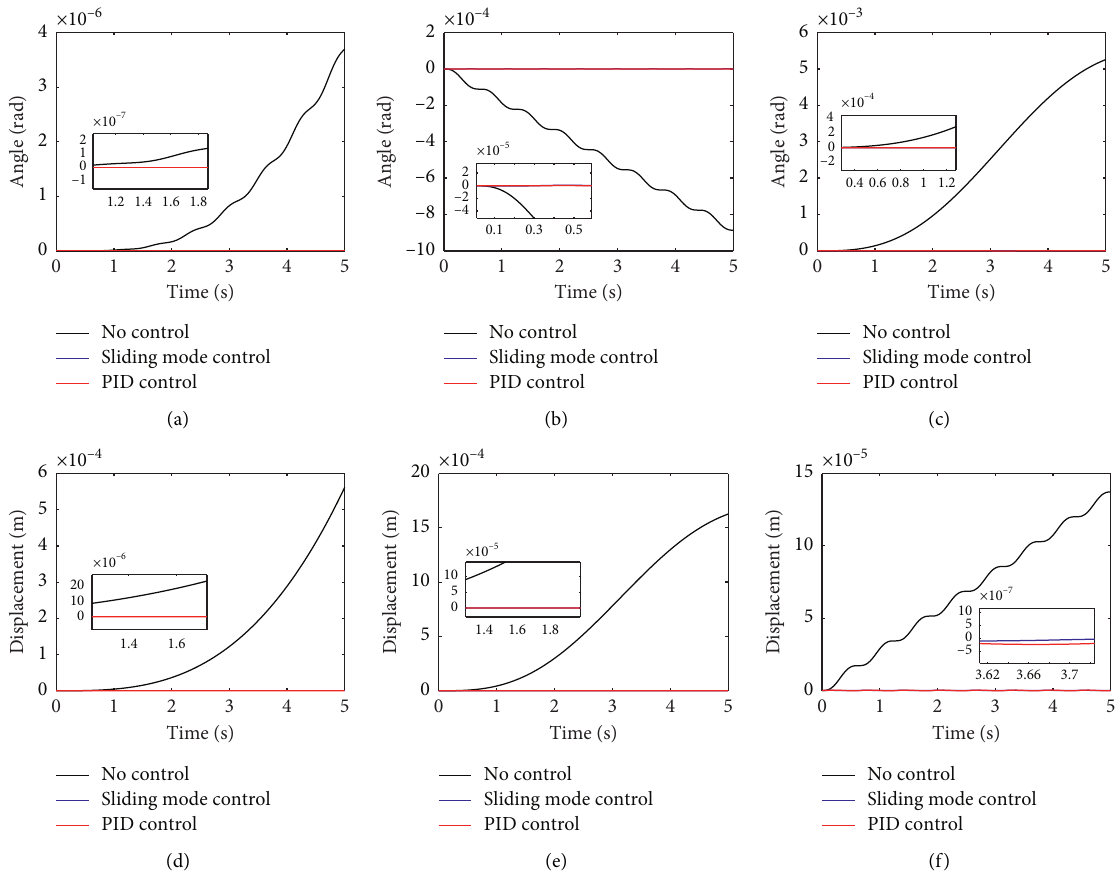
Figure 9: Floating platform position and attitude control: (a) θ